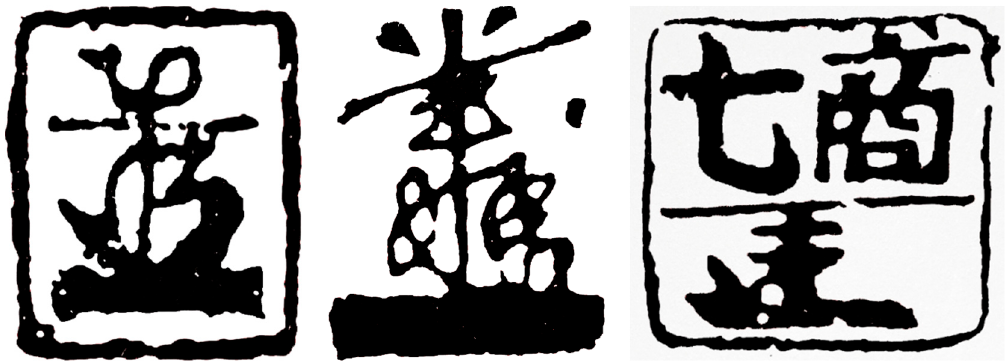
Figure 27. The Song Yuan Huaya in free style with two short lines (B type). The period of the Song and Yuan Dynasties. Sketched by author. Picture source: Shi (1995), pp. 52, 59.